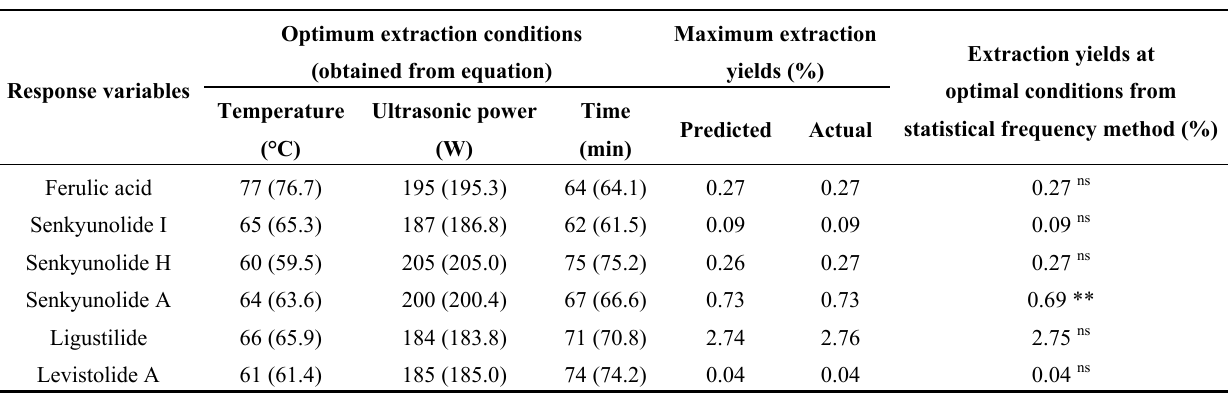
Table 4. Estimated optimum conditions, predicted and experimental values of responses under these conditions